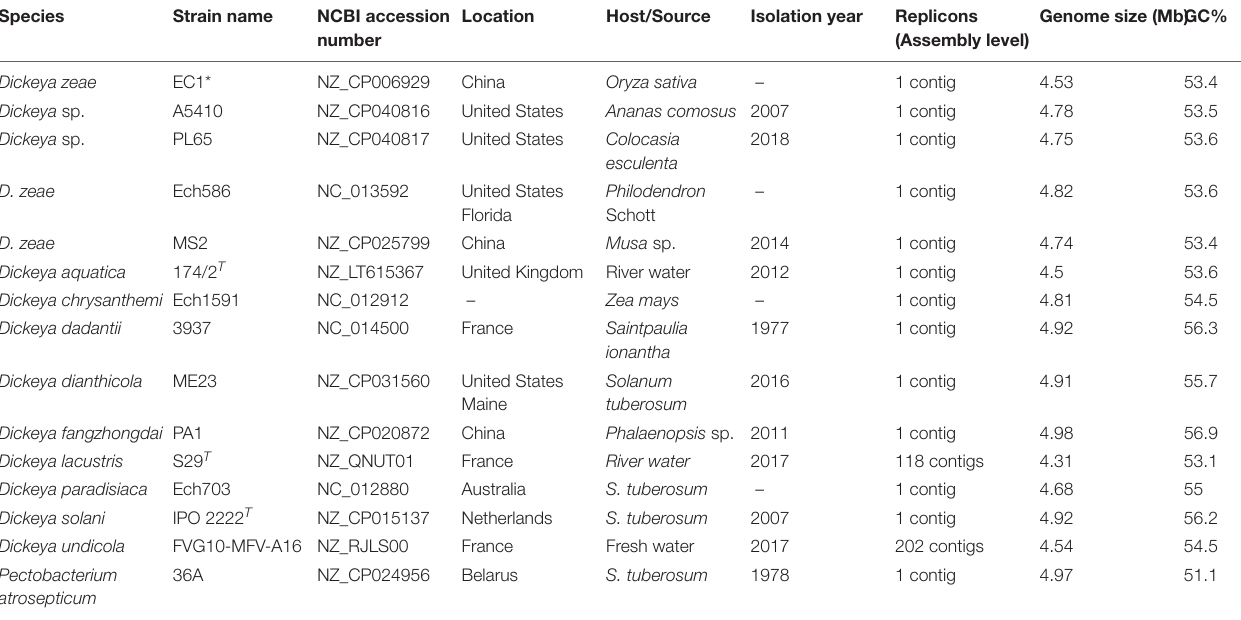
TABLE 1 | Selected genomes of Dickeya and Pectobacterium used for comparative and phylogenomic analyses.